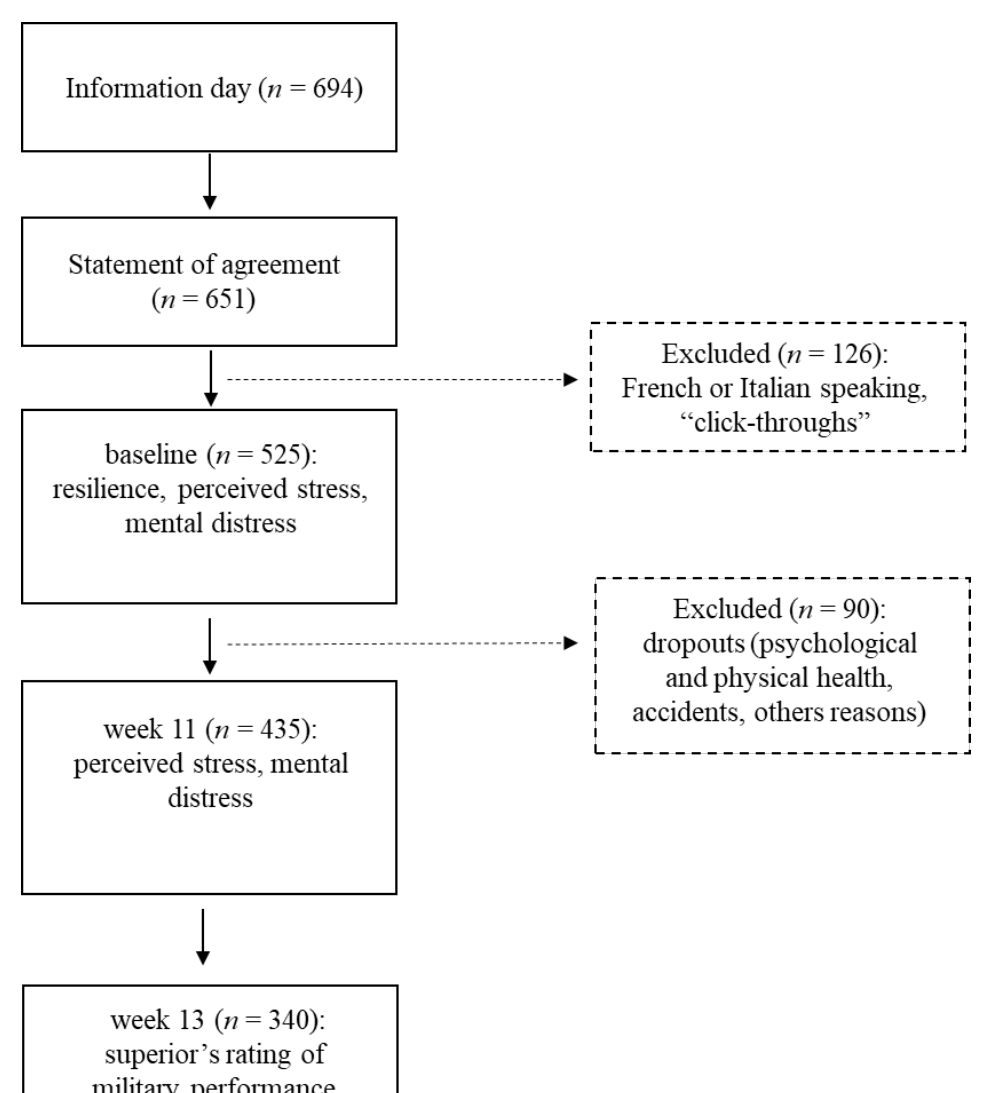
Figure 1. The flow chart shows the sample size of participants. In two examinations (baseline and at week 11), self-rating data covering demographic information and psychological dimensions of resilience, perceived stress, and mental distress were collected. In week 13, an expert rating was made of the military performance of the recruits.